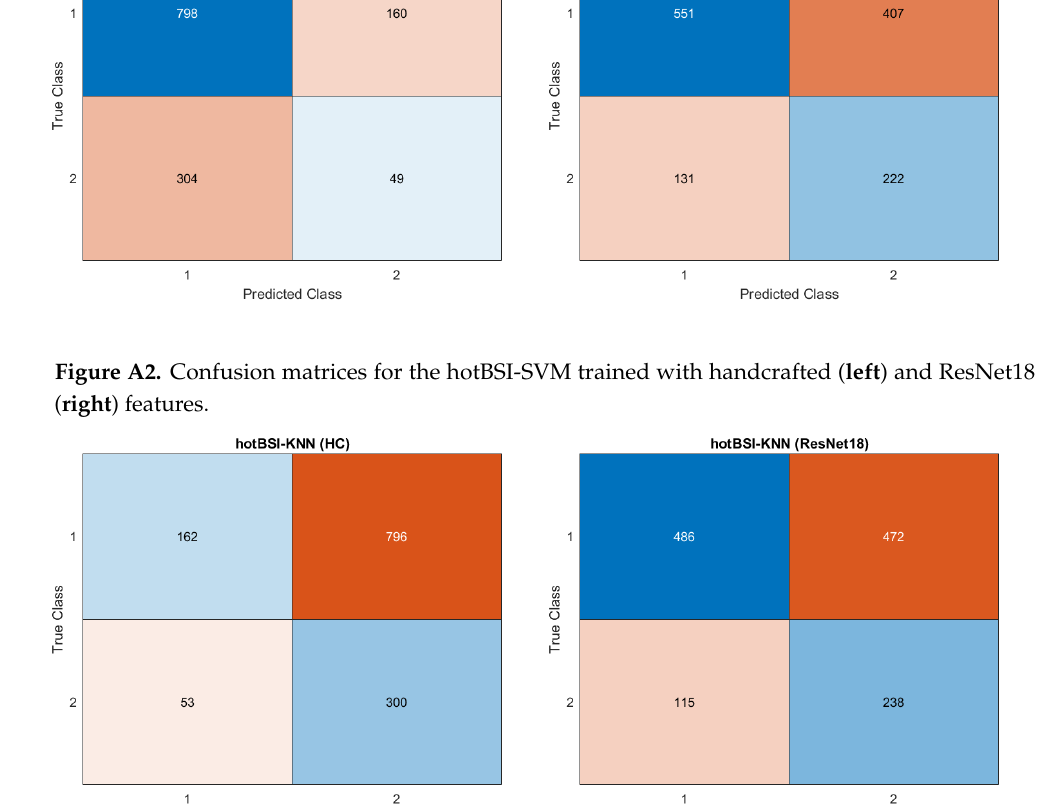
Figure A3. Confusion matrices for the hotBSI-KNN trained with handcrafted ( left ) and ResNet18 ( right ) features.